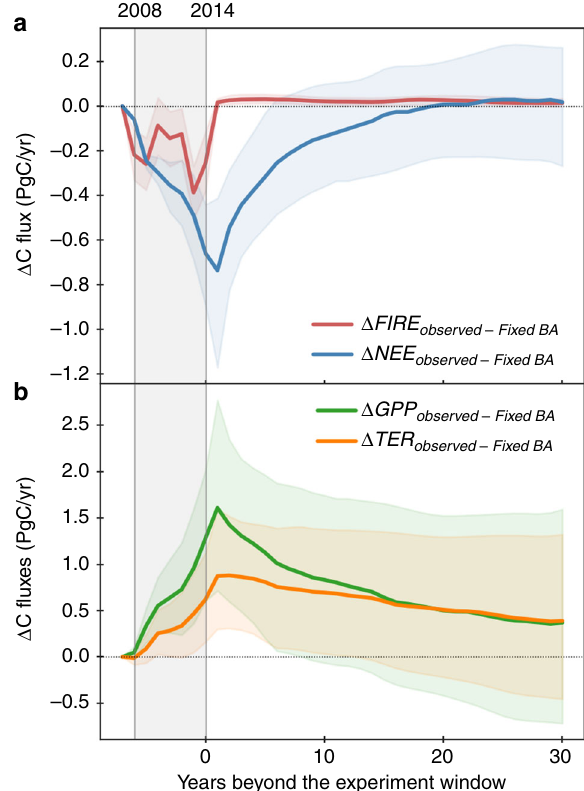
Fig. 3 Impacts of different BA scenarios on the global carbon cycle. a Relative differences in the simulated global fi re carbon emissions ( Δ FIRE) and net ecosystem exchange ( Δ NEE), and b Relative differences in the simulated global Gross Primary Productivity ( Δ GPP) and Terrestrial Ecosystem Respiration ( Δ TER) between the Observed BA and the hypothetical BA scenarios — Fixed BA. The lines show the model median and the shadings show the range between 1st and 3nd quartile. Different BA scenarios are only applied within the experiment window (2008 – 2014) as marked by the grey shade, resultant differences beyond 2014 represent legacy effects of different BA during 2008 – 2014. Actual meteorological data is used from 2001 to 2014, and the same forcing data is repeatedly used for all scenarios beyond 2014 including the Observed